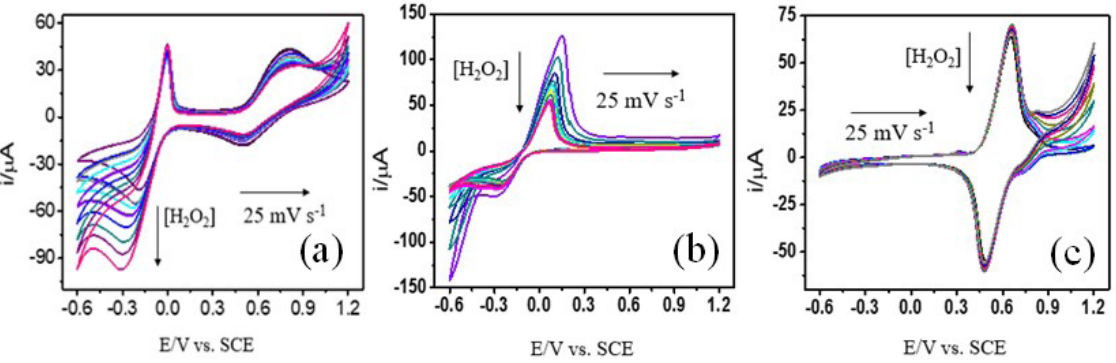
Figure 5. Cyclic voltammograms of the nanocomposite (a), CuO NPs (b) and Cu from 3.0 x 10 -4 to 3.0 x 10 -3 mol L -1 in acetate buffer (pH = 4.1), T = 25 °C, and a scan rate of 25 mV s -1